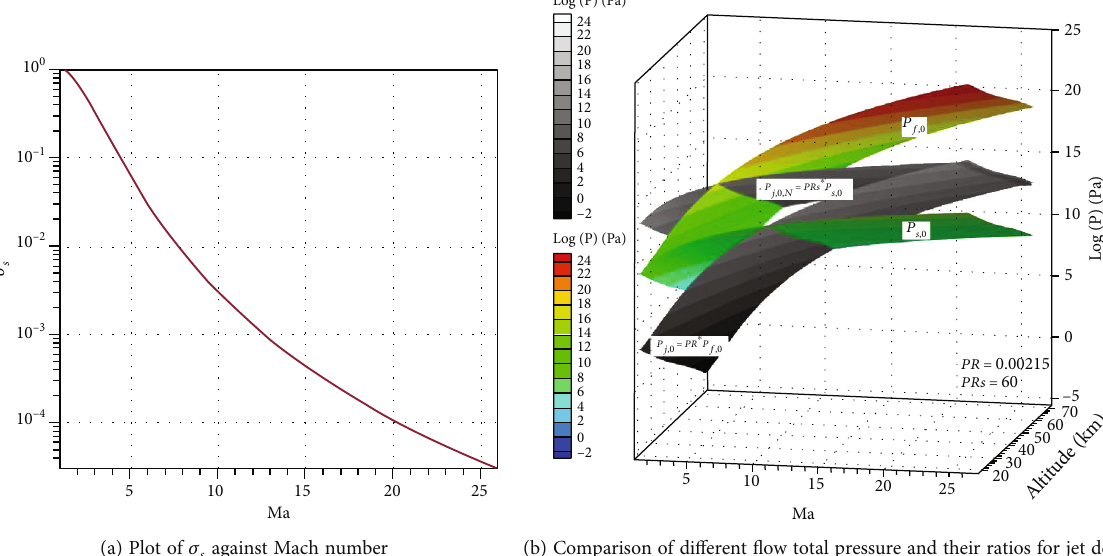
(b) Comparison of di ff erent fl ow total pressure and their ratios for jet design ff erent total pressure ratio. Figure 1: Plot of the total pressure ratio σ s versus the Mach number and comparison between di